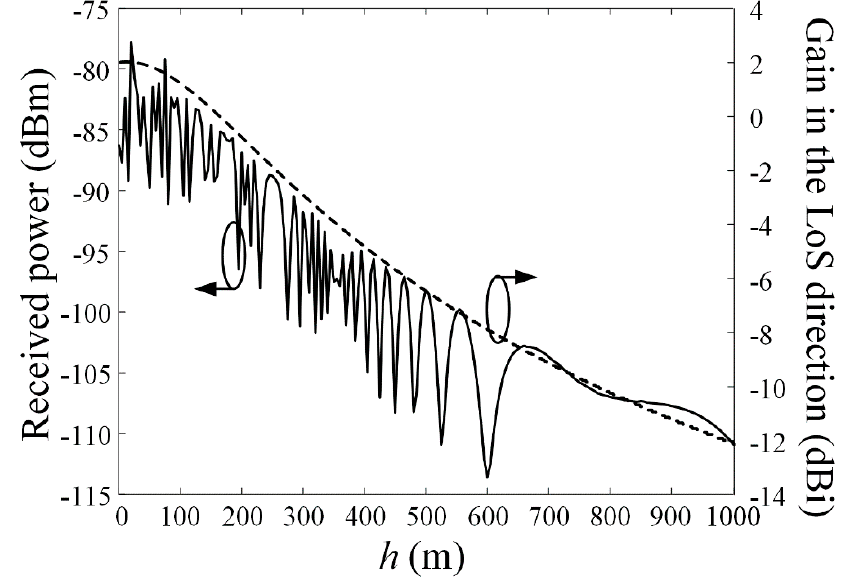
Figure 9. Received power and the gain in the LoS direction at p 2 .